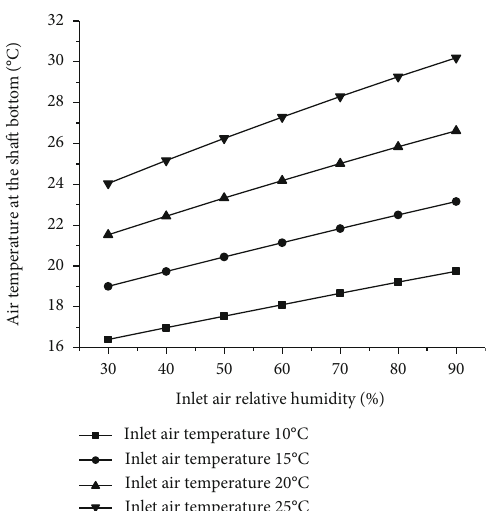
Figure 8: E ff ect of the inlet air temperature and humidity of inlet air on the air temperature at the shaft